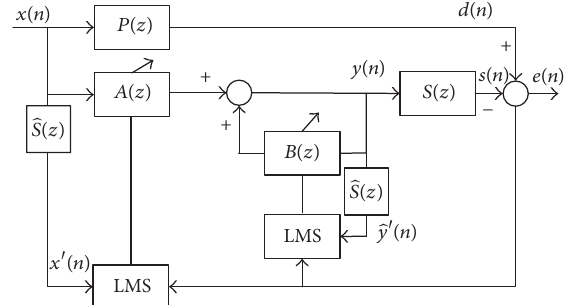
Figure 2: Schematic diagram for a duct-like application.